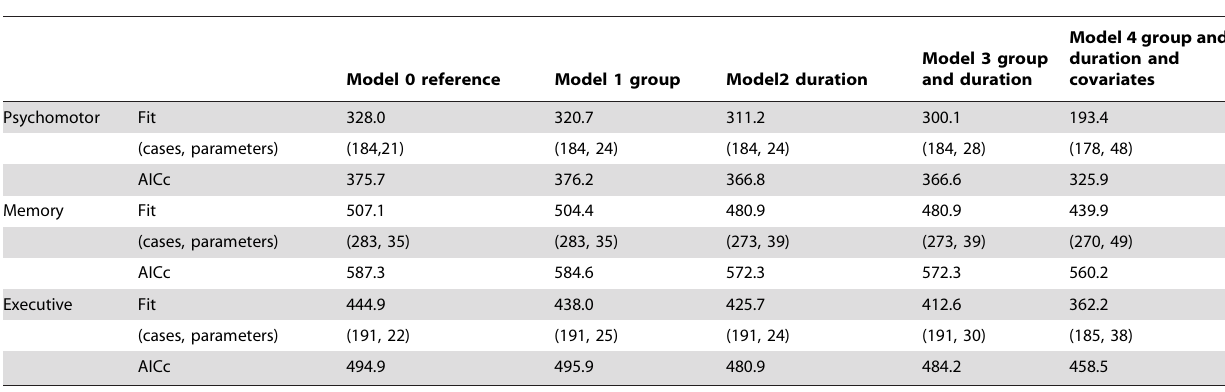
Table 3. Statistical outcomes of the multivariate